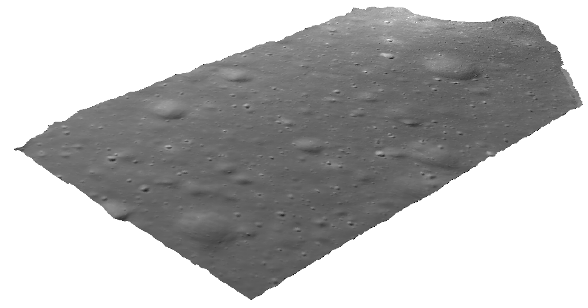
Figure 5. DOM overlaid on DEM generated form CE-3 descent camera (0.4m-resolution)